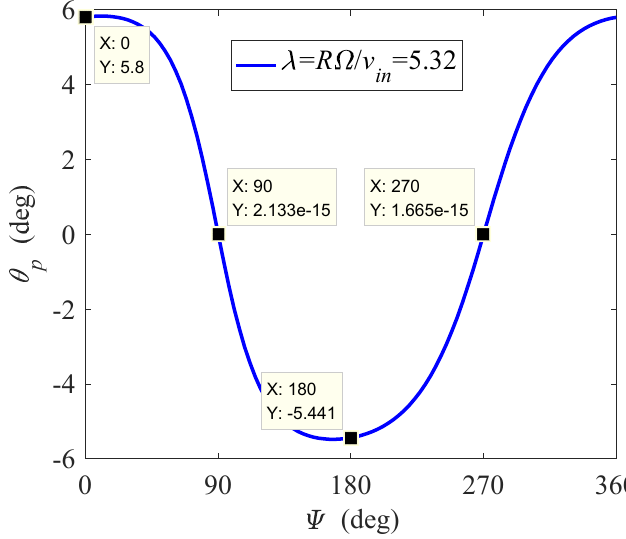
Figure 23. Variation of the optimized pitch angle with the azimuth.